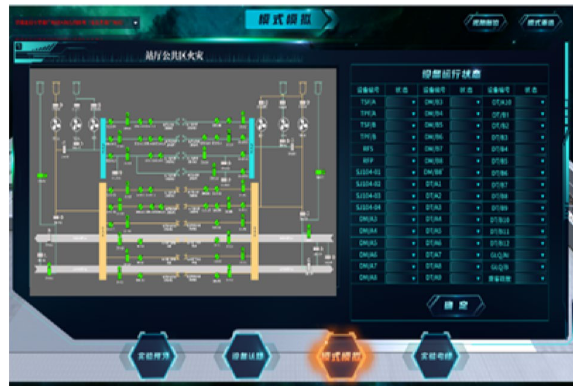
Figure 10. Ventilation control mode design interface.